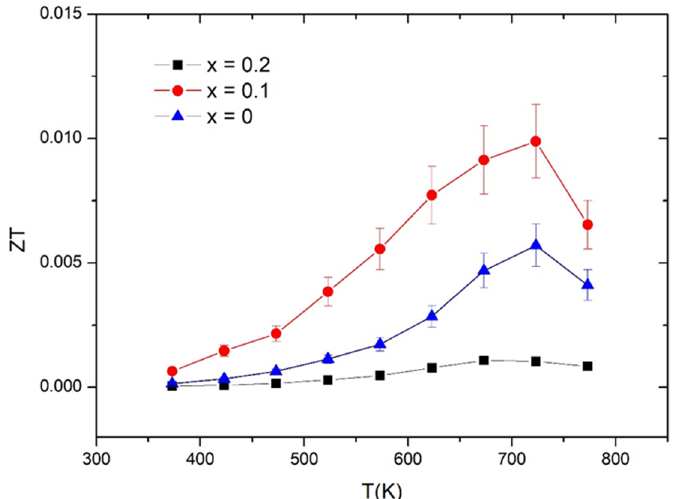
Figure 7. Temperature dependence of the figure of merit, ZT, of Sr 1-x Ti 0.9 Nb 0.1 O 3 − δ (x = 0, 0.1, 0.2). error bars of ± 15% are indicated in the graph. This is based on the addition of 5% error for the Seebeck coefficient, 5% for the thermal conductivity, and 1.5% for the electrical resistivity error (obtained after three repetitions of the measurements).